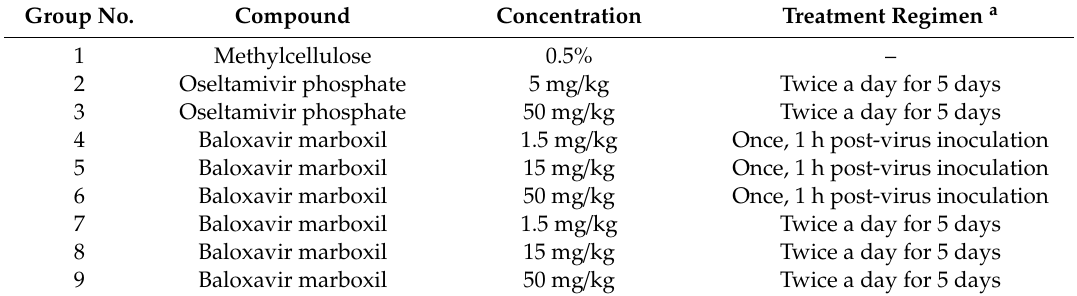
Table 1. Summary of treatment groups.